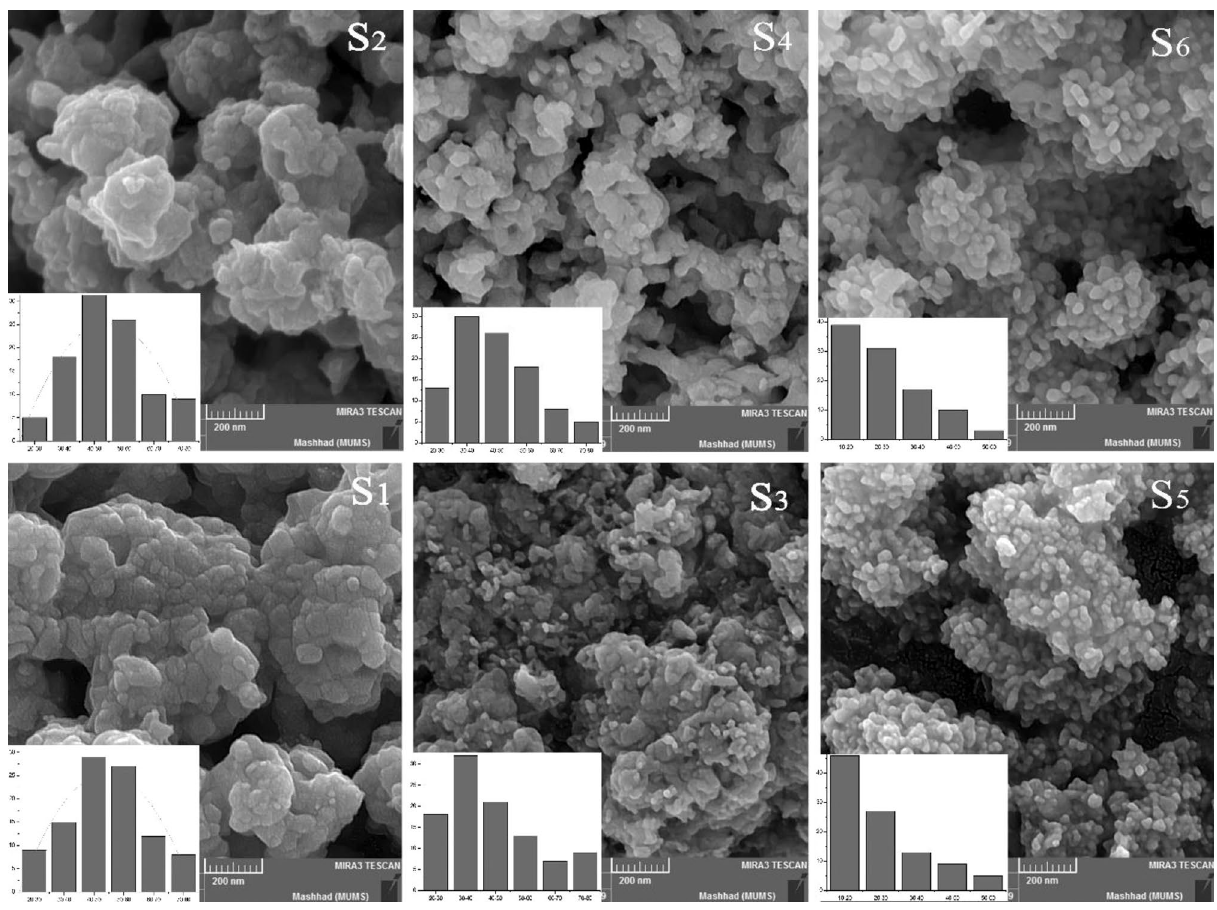
Figure 4. Effect of natural essence type on the morphology and the particle size distribution of synthesized NiO